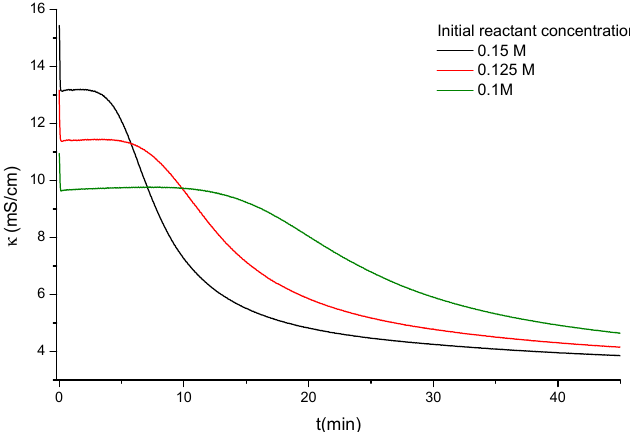
Figure 5. Effect of increasing reactant concentration on the conductivity vs time profiles of the reaction of MgSO 4 + Ca(OH) 2 + 2 H 2 O → Mg(OH) 2 + CaSO 4 ·2H 2 O. During the reactions, the additive-to-reactant ratio was held constant (the molar ratio of Ca:Mg:citric acid = 0.1:0.1:0.0015), the initial reactant concentrations are shown in the figure (T = 20 °C; in distilled water media without any supporting electrolyte).